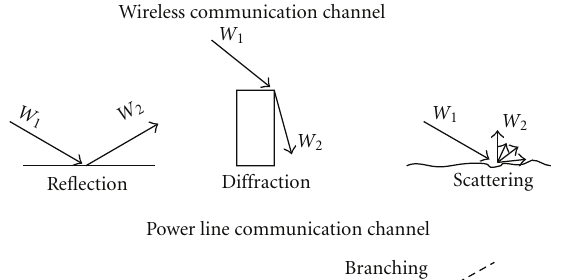
Due to the propagation mechanisms e ff ective in both environments, when a signal is emitted by a transmitter, the signal received at the receiver consists of attenuated, delayed, and phase-shifted replicas of the transmit signal leading to time dispersion. In communications community, significance of time dispersion is quantified by a param- eter called root-mean-squared (RMS) delay spread.